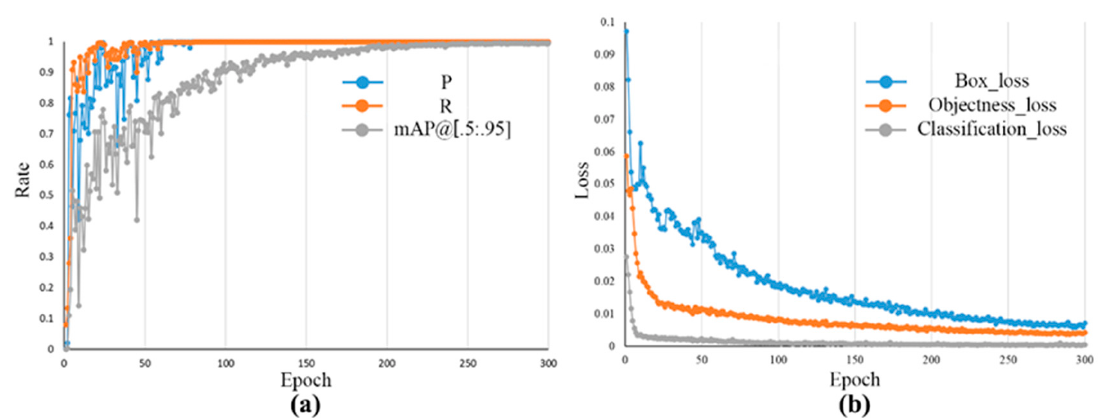
Figure 8. ( a ) P, R, and mAP@[0.5:0.95] curves with the number of training epochs. ( b ) Plots of the box loss, object loss, and classification loss during training.